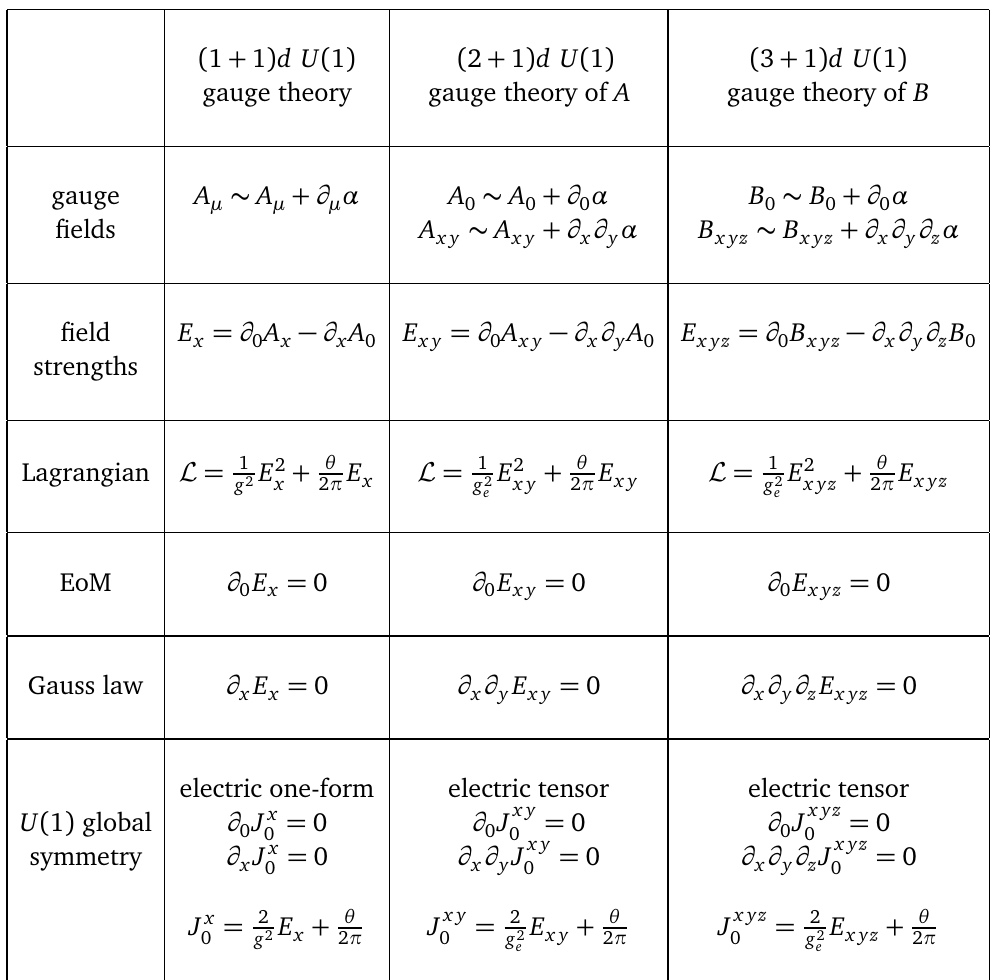
Table 2: Analogy between the 1 + 1-dimensional U ( 1 ) gauge theory, the 2 + 1- dimensional U ( 1 ) gauge theory of A in [ 3 ] , and the 3 + 1-dimensional U ( 1 ) gauge theory of B in Section